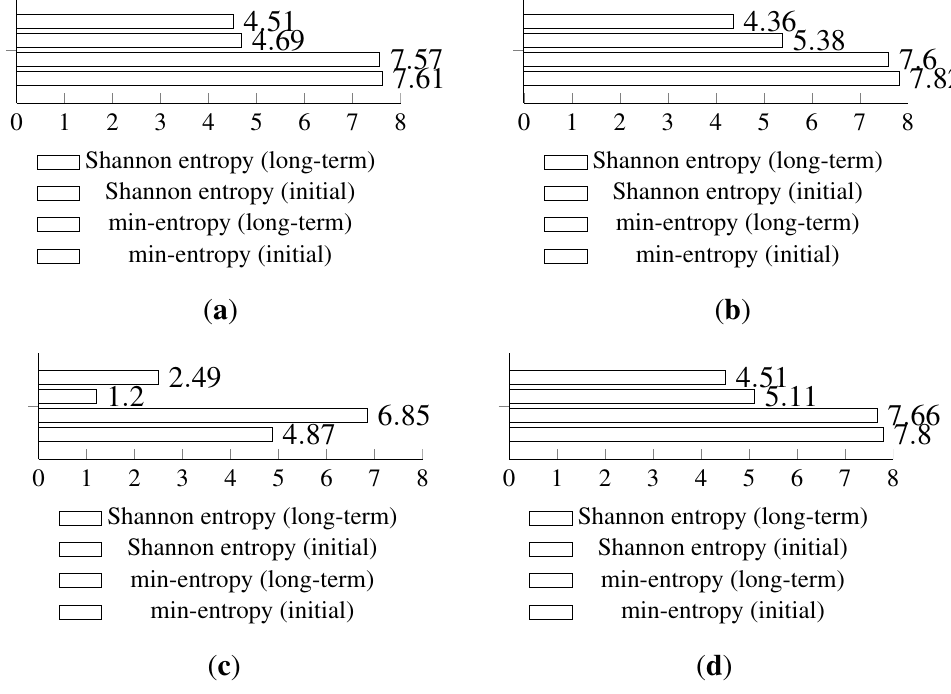
Figure 8. Comparison of Shannon entropy and min-entropy estimations of random bytes of the long-term experiment and the initial results of the analyzed sensors by particular entropy harvesting methods. ( a ) Light (1); ( b ) Light (2); ( c ) humidity; ( d )